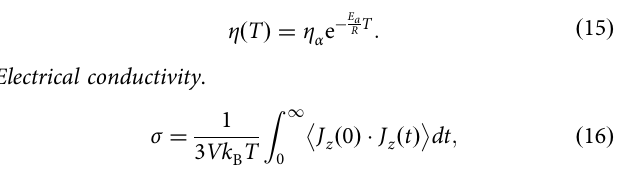
and can be derived from the bond angle shown below. Bond angle . The bond angle is de fi ned as: